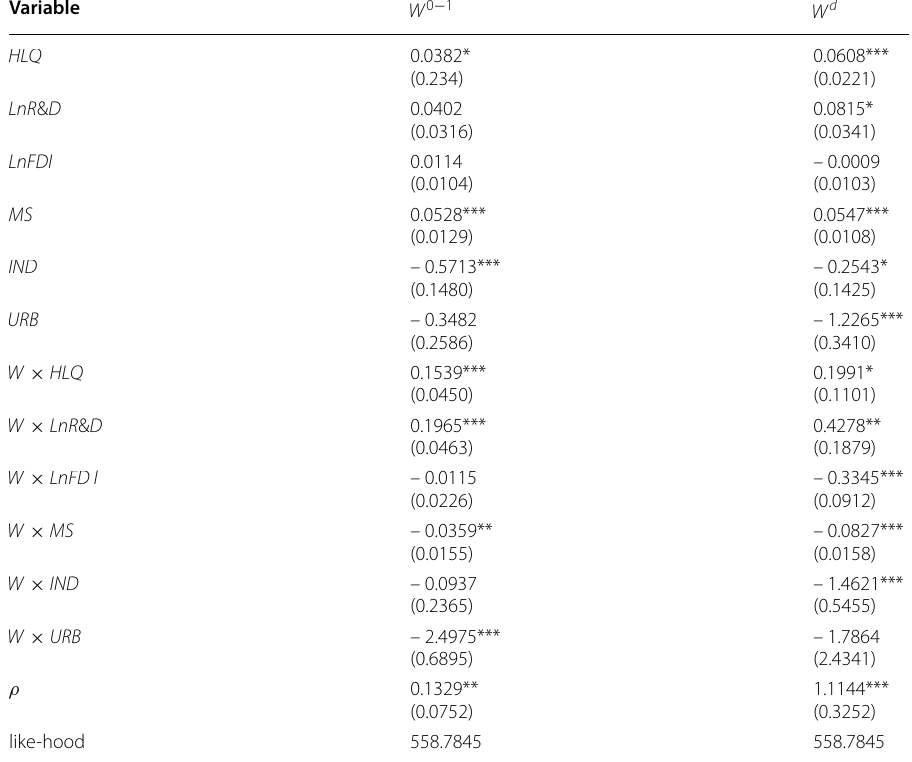
Table. 4 Model estimation